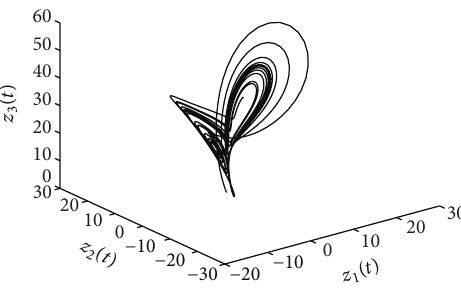
Figure 1: Chaotic trajectory of system